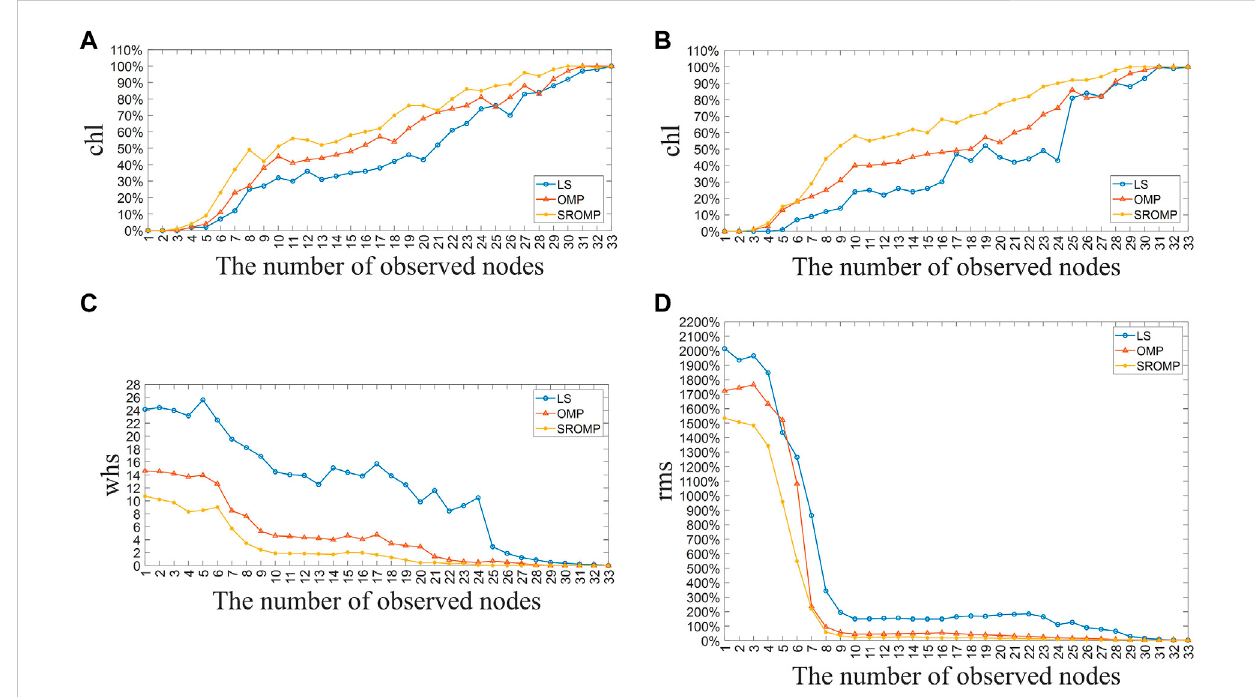
FIGURE 5 Analysis result of 7th harmonic. (A) chl of Node 19. (B) chl of Node 29. (C) whs of 7th harmonic. (D) rms of 7th